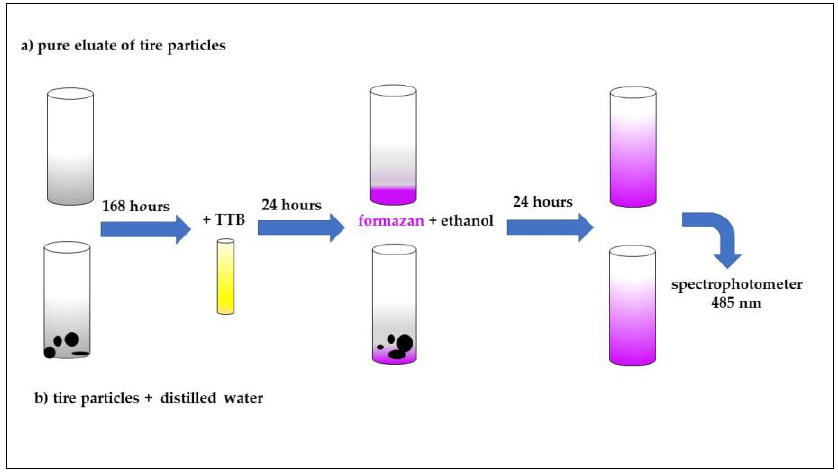
Figure 2. Scheme of experimental designs (MTT viability assay)—preparation of